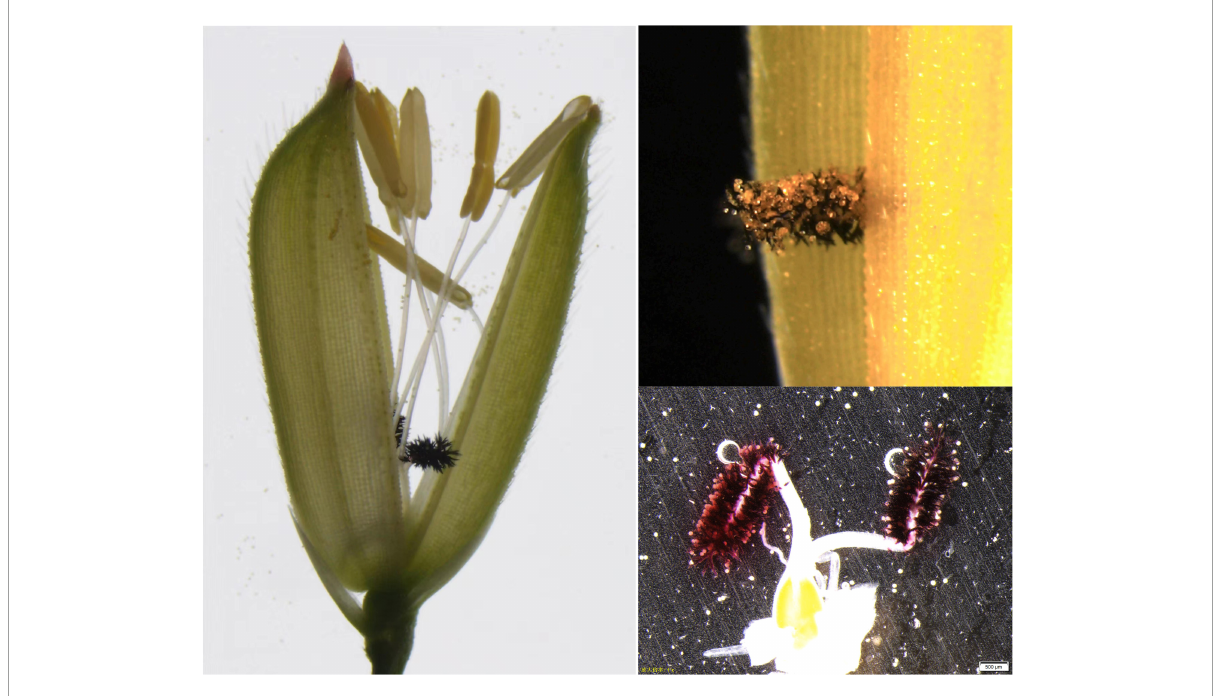
FIGURE2 Illustration of the pollination advantage of the exserted